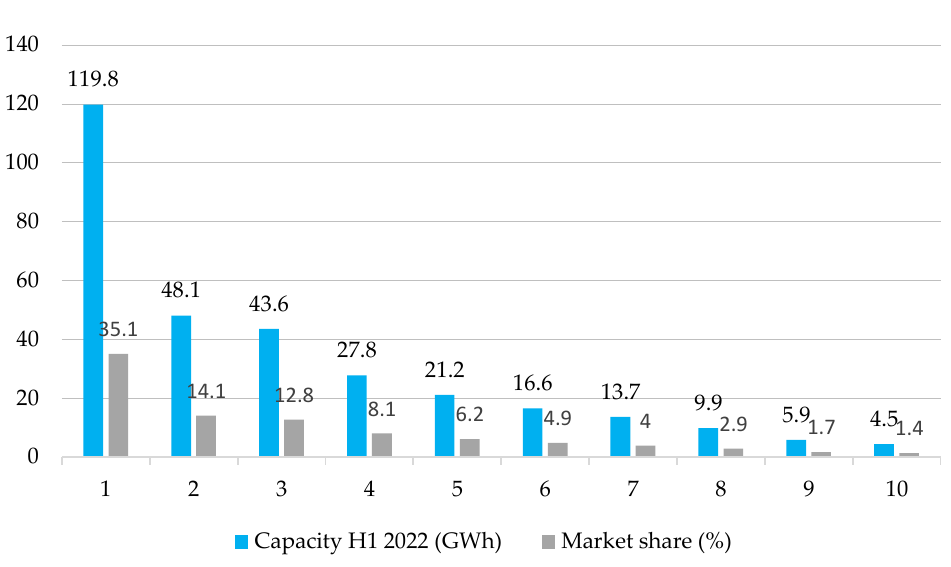
Figure 3. The largest manufacturers of batteries for electric vehicles, January to September 2022: 1 — CATL; 2 — LGES; 3 — BYD; 4 — Panasonic; 5 — SK on; 6 — Samsung SDI; 7 — CALB; 8 — Gotion Hihg- Tech; 9 — Sunwoda; 10 — SVOLT.